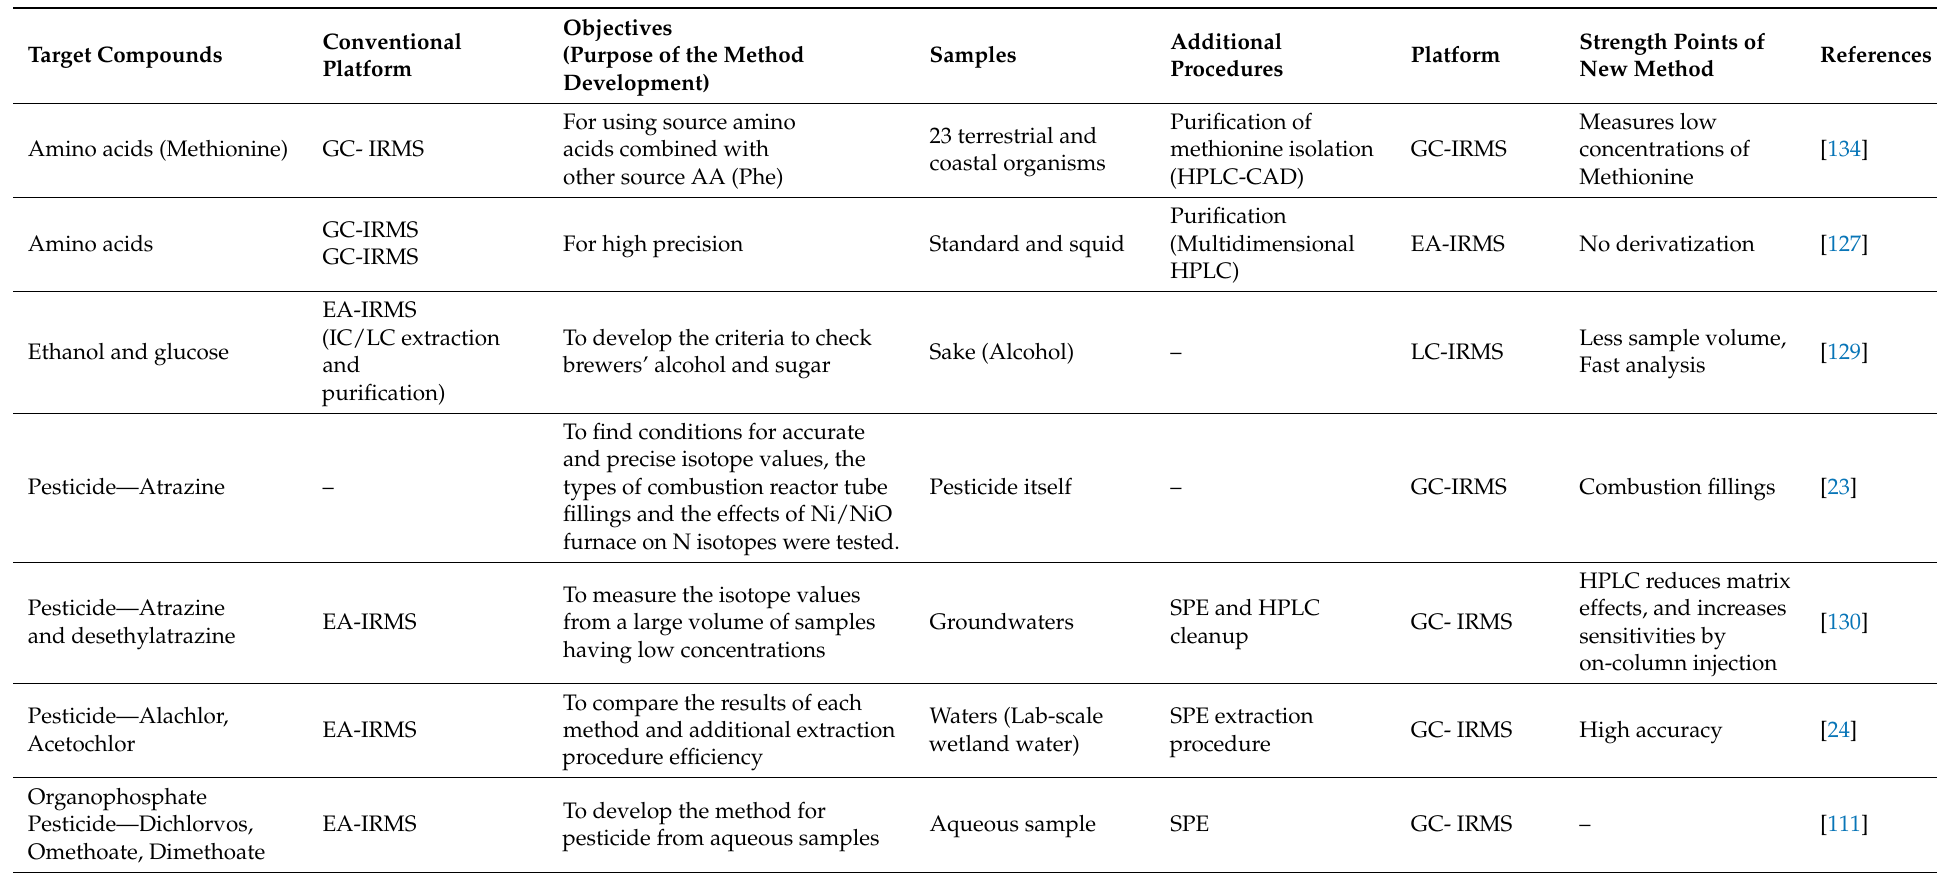
Table 3. Examples of studies that developed or used a new intermediate course for IRMS analysis for pesticides and other